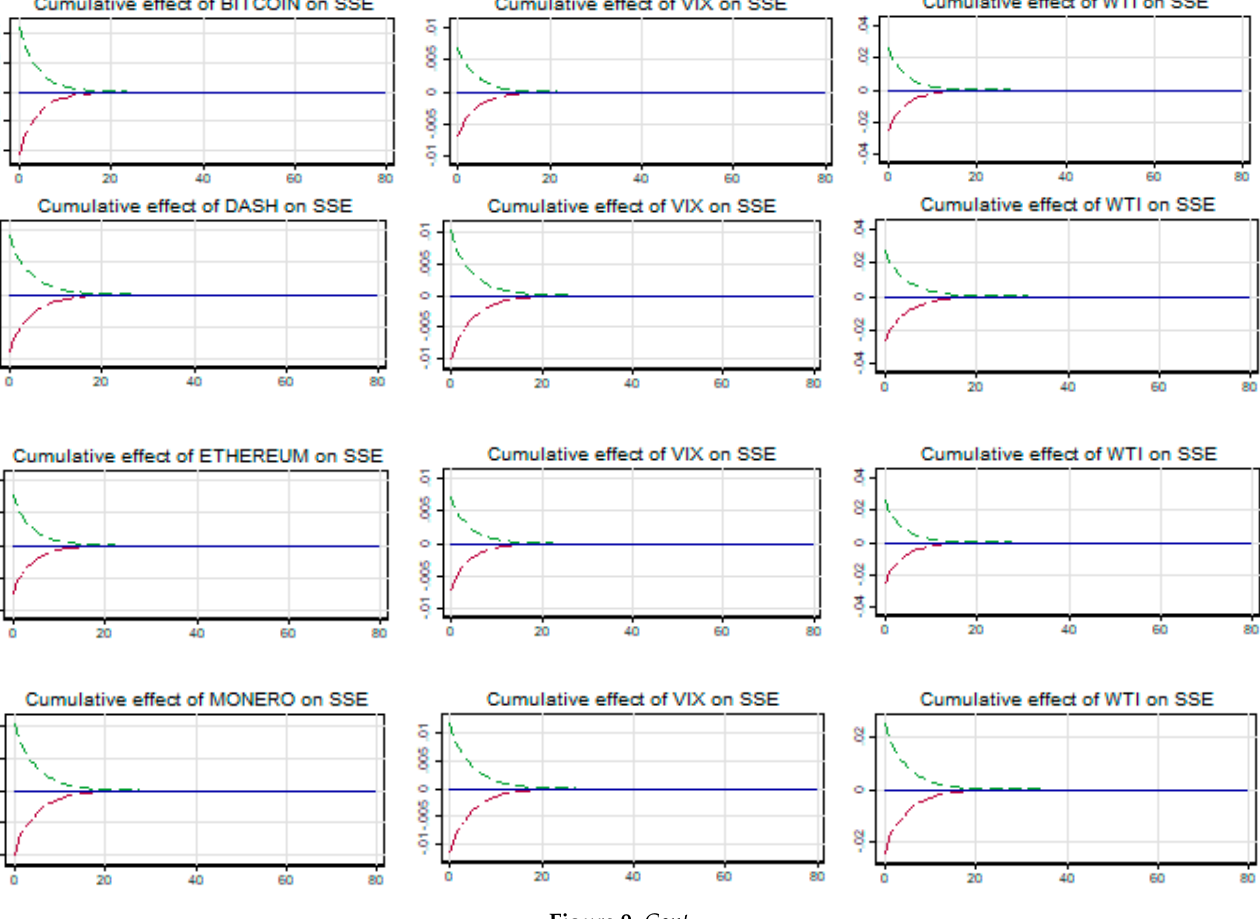
Figure 9. Cumulative effects of cryptos and gold on SSE. 4.2.5. RTSI The relationship between RTSI and cryptocurrencies and RTSI and gold are symmet- ric both in the short and long run as evidenced from the results in Table 14. The long-run cointegrating coefficient is significant and negative with Ethereum, thereby establishing a strong safe haven property. Thus, in the COVID-19 financial market crisis, Ethereum can be part of the RTSI equity portfolio in order to obtain a safe haven benefit. RTSI has a significant and positive relationship with Dash, thus rejecting any kind of safe haven op- portunity. However, weak safe haven opportunity is found with Bitcoin, Monero, and Ripple as the long-term cointegrating coefficient is not significant, implying no relation- ship. Furthermore, gold shows a strong safe haven property with RTSI as the long-term cointegrating coefficient is negative and significant. This safe haven and its stability are further ratified in all cryptocurrencies except Dash and including gold by the cumulative multiplier presented in Figure 10. As evidenced from the graph, any short-term shock on